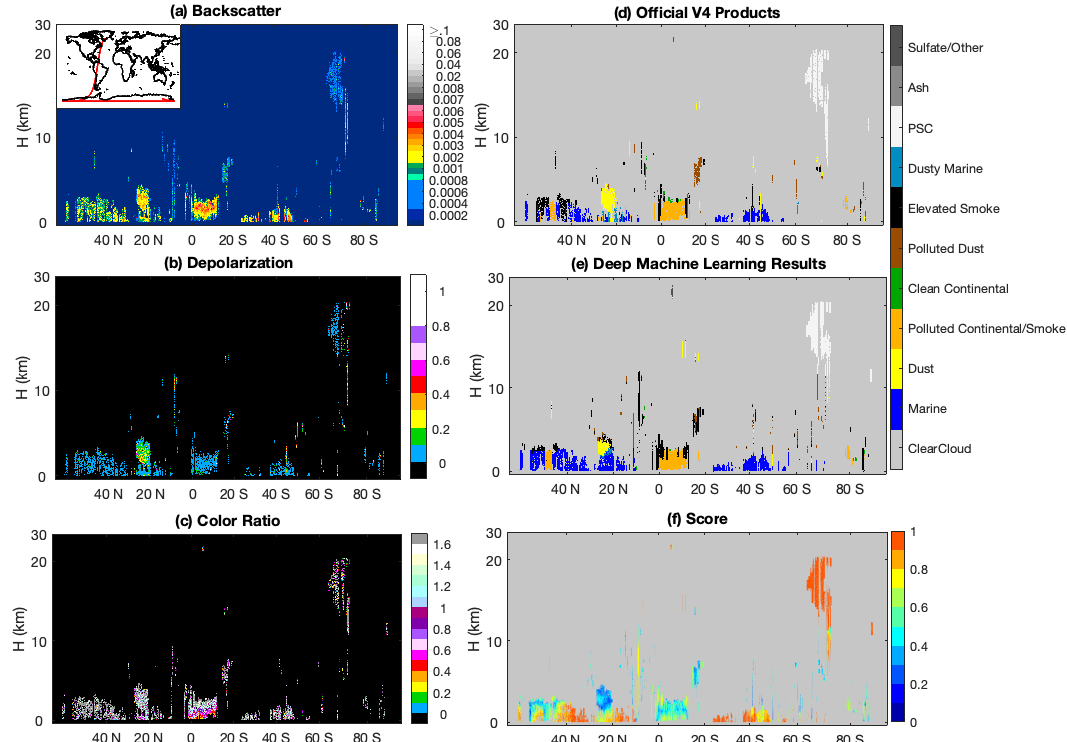
Figure 3. CALIOP measurements and aerosol classification results for nighttime data acquired on 17 August 2010, starting from 05:56:13 UTC. ( a – c ) The 532 nm backscatter intensity, volume depolarization, and attenuated total backscatter color ratio measurements, respectively. The CALIPSO ground track is overlaid in the upper-left corner of panel ( a ). ( d ) The aerosol classifications reported by the CALIOP operational scene classification algorithms. ( e ) The classifications determined by the trained convolutional neural network. ( f ) The CNN classification scores.